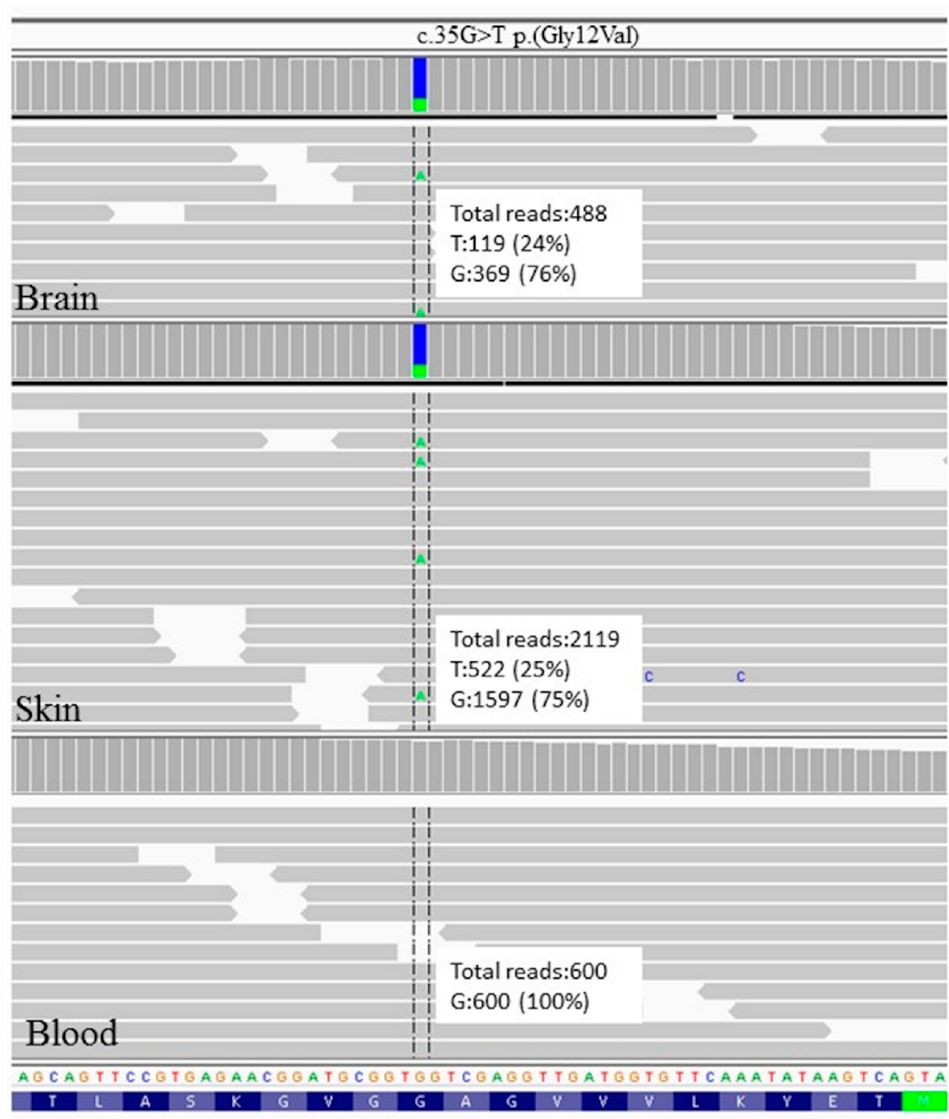
Figure 4. Next-generation sequencing data from brain, skin, and blood samples showing the presence of the c.35G > T (p.Gly12Val) KRAS mutation with a ~25% mosaicism rate both in brain and skin tissue, but absence of the variation in the blood sample, thereby demonstrating the somatic origin of the mutation.